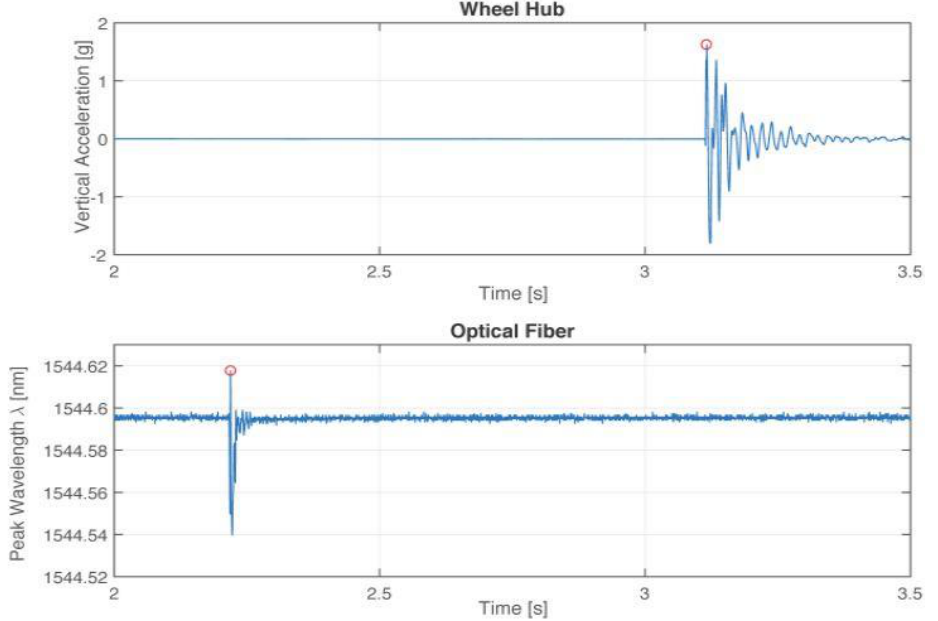
Figure 16. Raw data appearance before synchronization: ( top ) the time history of the vertical acceleration, in g, of the wheel hub, and ( bottom ) the time history of the peak wavelength 𝜆 𝐵 of the FBG sensor, in nm.